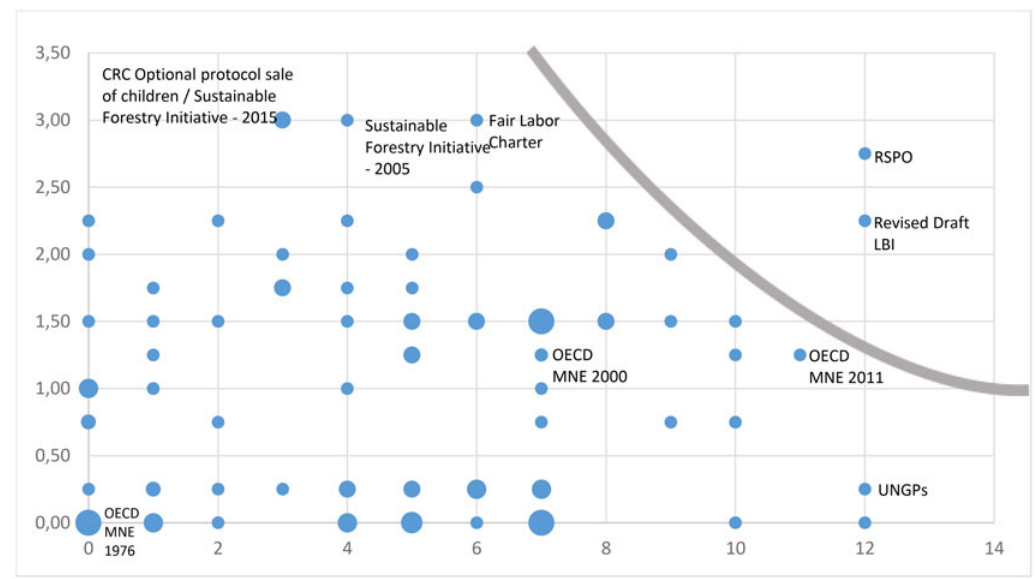
Figure 3. Updated Commitment Curve: Accountability Versus Human Rights